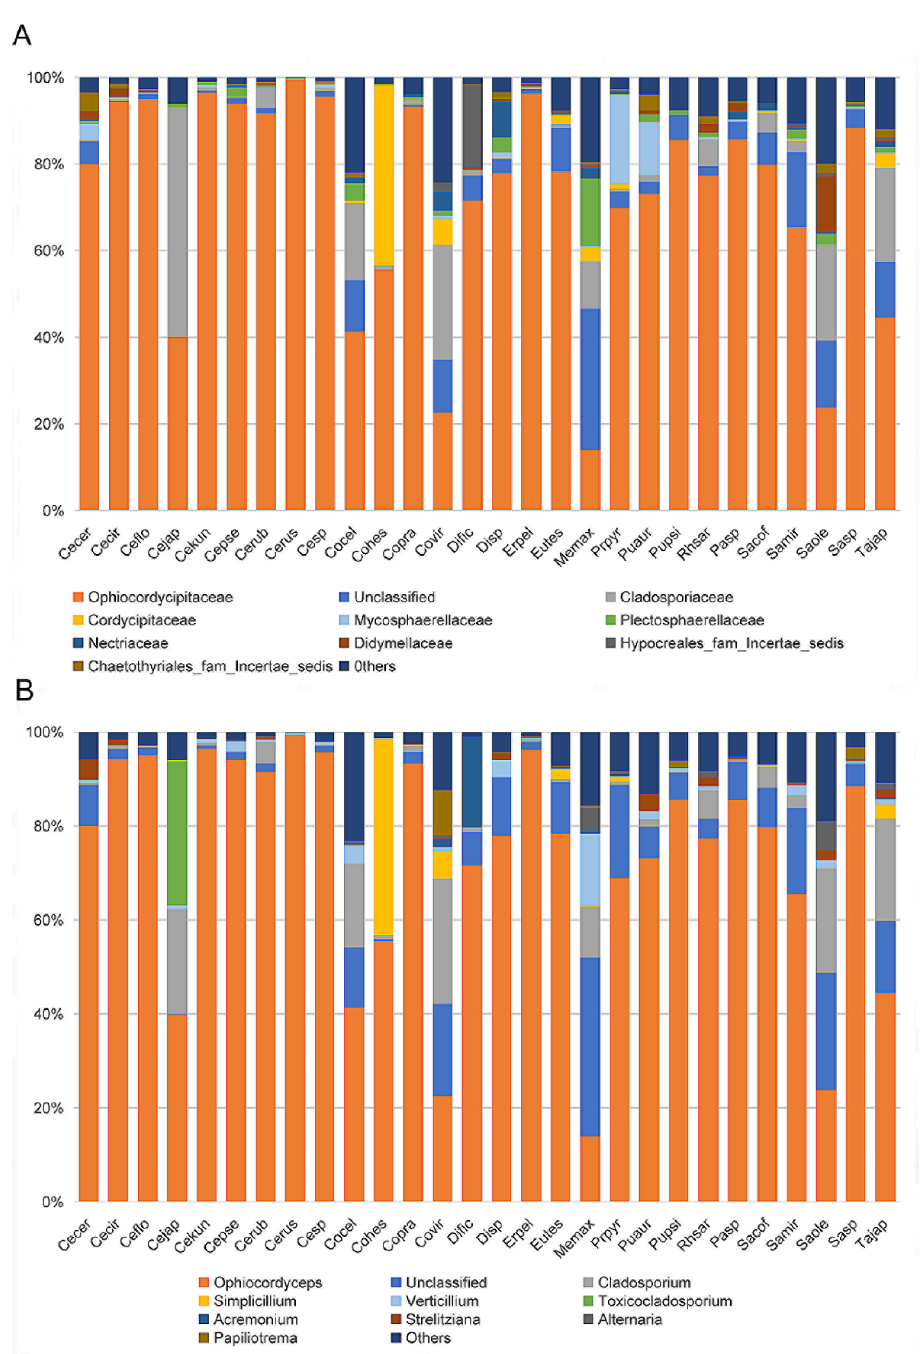
Figure 5. Relative abundance of fungi in 28 Coccidae species at family ( A ) and genus ( B ) levels after some unclassified operational taxonomic units (OTUs) were confirmed as Ophiocordyceps species. Species Abbreviations are the same as those in Figure 3.